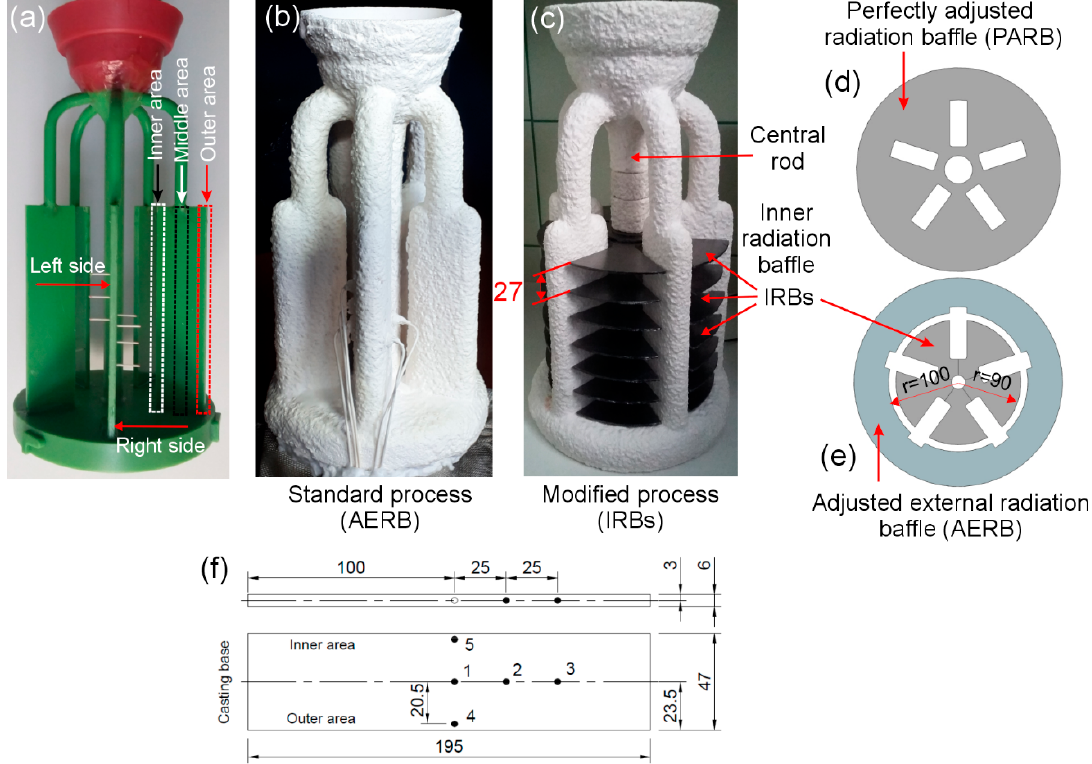
Figure 1. Wax model assembly ( a ); ceramic shell mold with mounted thermocouples without ( b ) and with introduced inner radiation baffles ( c ). Design of ring-shaped adjusted external radiation baffle (AERB) and inner radiation baffle (IRB) ( e ) as well as perfectly adjusted radiation baffle ( d ) which were used in experiments ( e ) and simulations ( d , e ). Geometric model (in mm) of plate casting with the location of measurement points (1–5) of temperature ( f ).